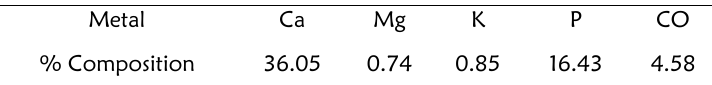
Table 3: Chemical composition of cow bone powder (wt%)